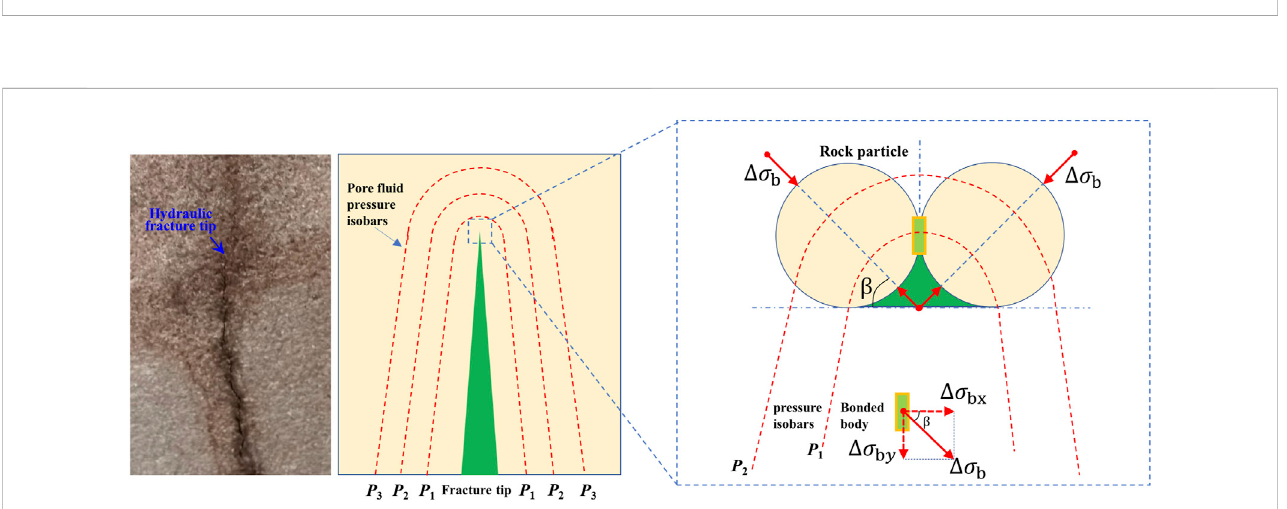
FIGURE 4 Stress diagram of rock unit on the left wall of the crack: additional stress due to water pressure gradient.